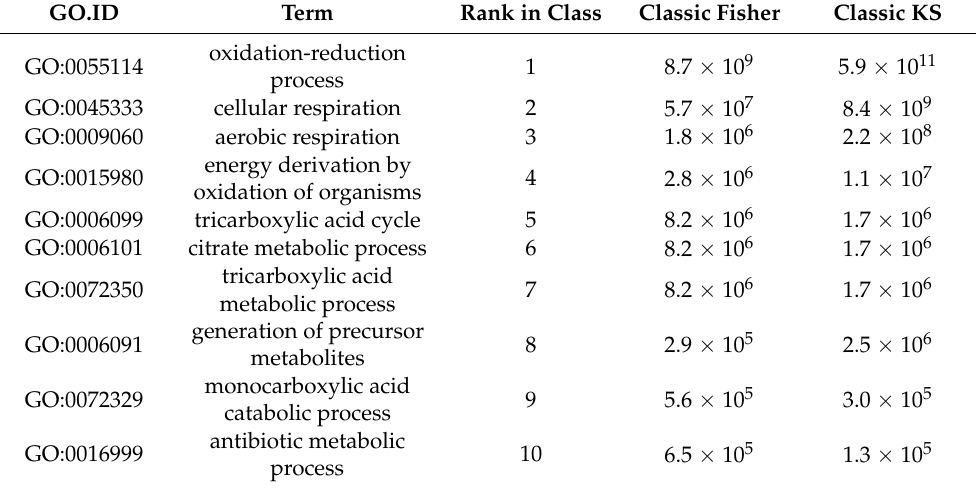
Table 1. Top 10 Significant GO Terms. Enrichment analysis on top GO terms for biological processes was conducted using Fisher analysis, where each GO category was tested independently. 488 GO terms were scored with 22 terms with p < 0.01. Classic Kolmogorov–Smirnov test was also used to test for enrichment, with 24 terms scored with p < 0.01. Annotated genes were 948, significant genes were 297, the minimum number of annotated genes to a GO term was 10, and nontrivial nodes were